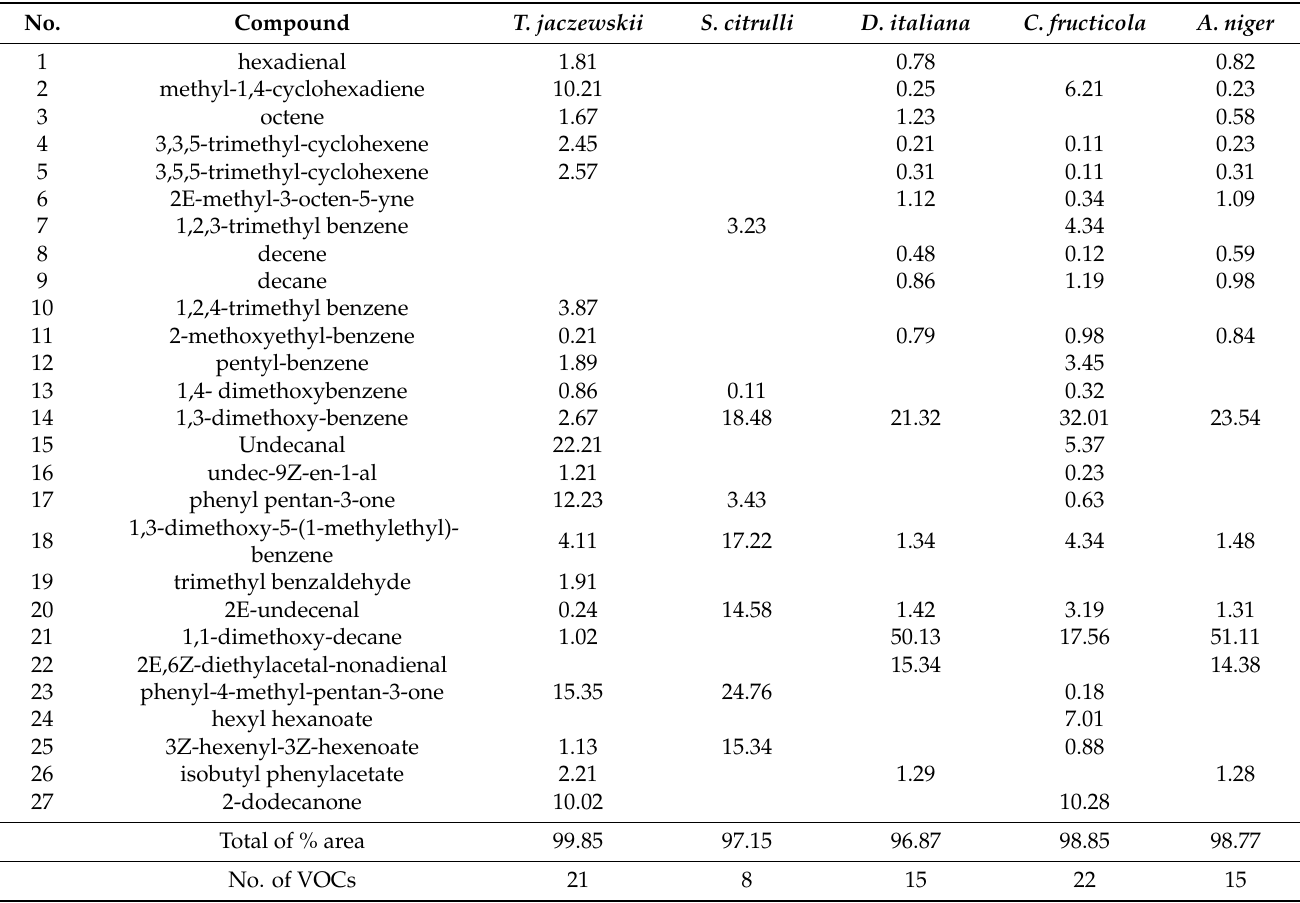
Figure 11. GC-MS chromatograms of dichloromethane extracts of LDPE films cultured with T. jaczewskii ( A ), S. citrulli ( B ), A. niger ( C ), D. italiana ( D ), and C. fructicola ( E ) after 90 days of incubation, respectively. Table 1. VOCs emitted from LDPE films cultured with T. jaczewskii , S. citrulli , A. niger , D. italiana , and C. fructicola after 90 days of